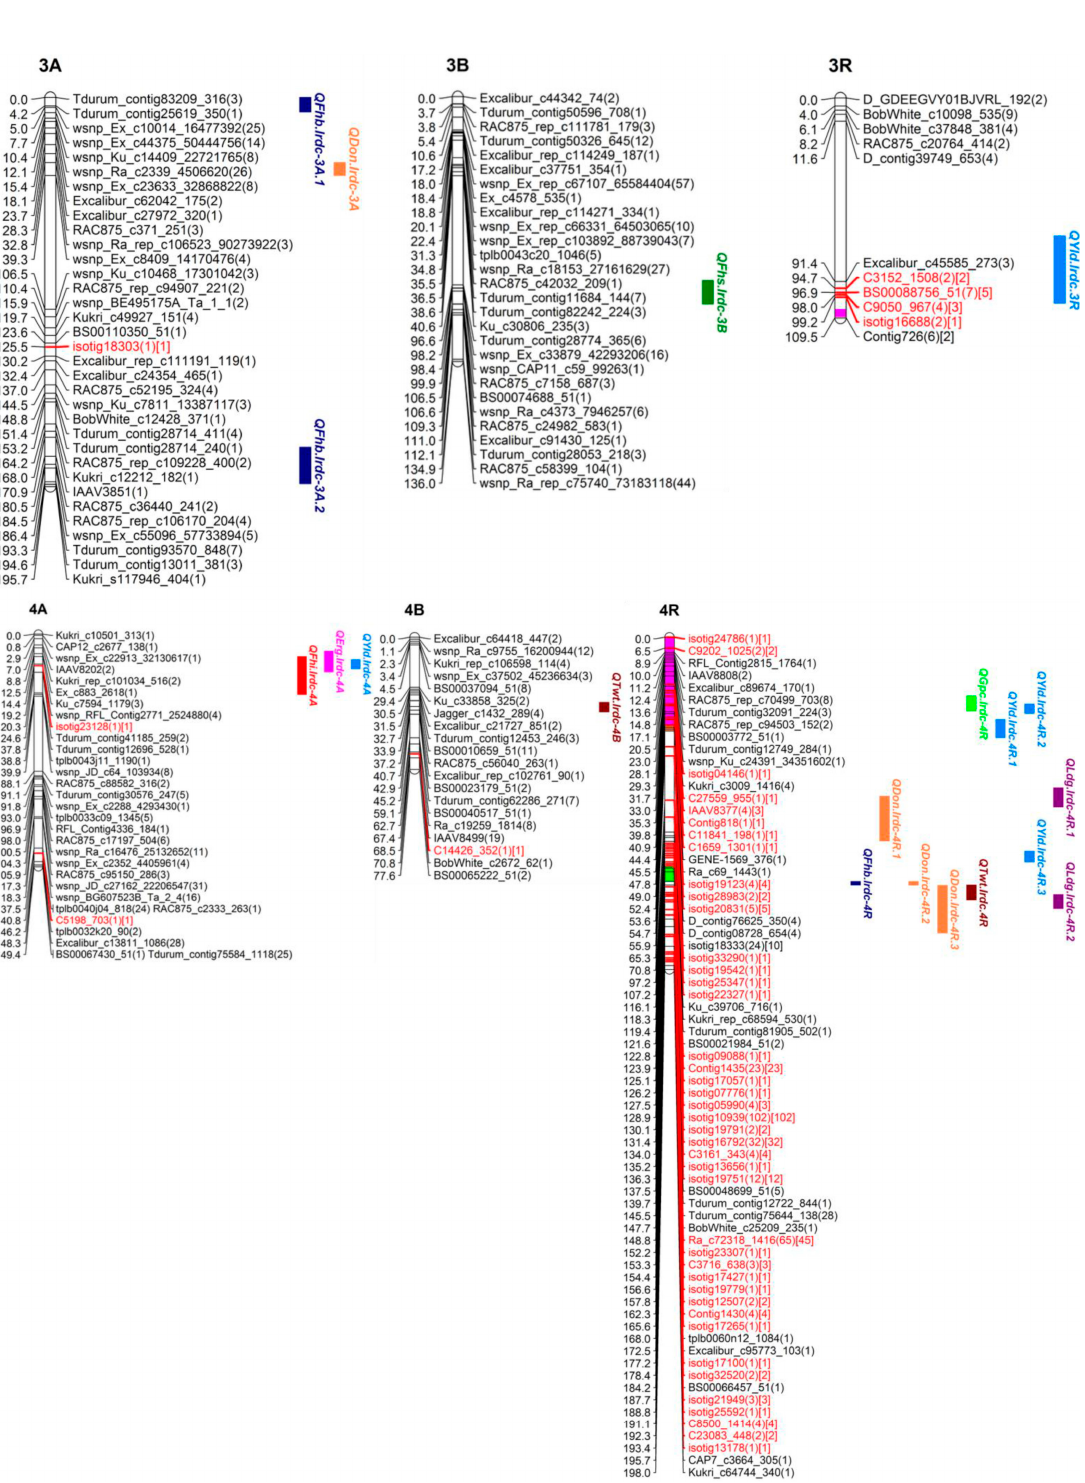
Figure 5. Homoeologous groups 3 and 4 SNP map of TMP16315/AC Ultima triticale DH population. Loci on chromosome maps are represented by unique markers. Marker names in black and red colors represent genomic regions largely dominated by SNPs derived from wheat genomes A/B/D and rye genome R, respectively. Numbers in round brackets represents total number of SNPs at the locus and number in square brackets represents SNPs derived from R genome. Colored chromosome bar indicates interchanged/translocated fragment (pink: chromosome (chr) 6R; green: chr 7R; brown: mosaic of chrs. 1, 2, 4, 5, 6 and 7). The QTL for different traits are given on the right side of maps.